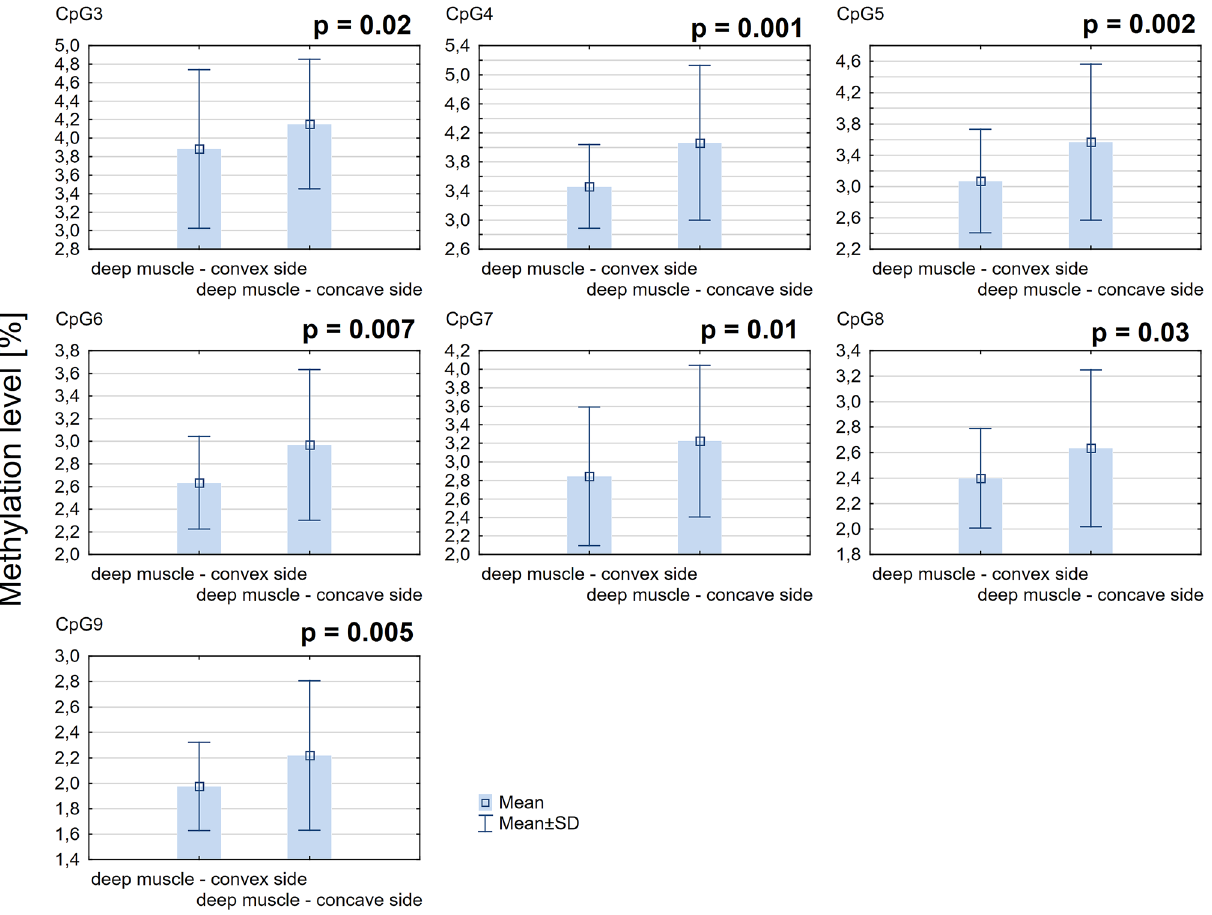
Figure 2. DNA methylation level in seven CpG sites localized within ESR2 promoter 0N in deep paravertebral